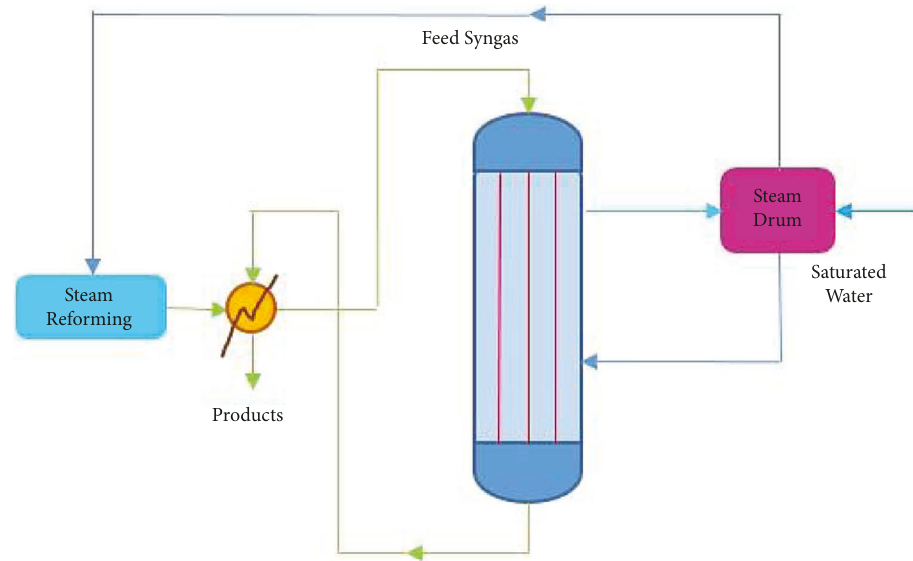
Figure 2: Diagram of F-T reaction process